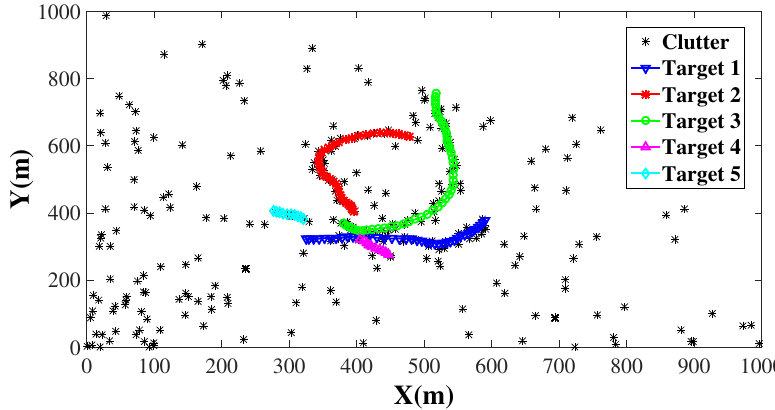
Figure 2. Ground-truth trajectories of five targets with the clutter number setting to be 10. The target trajectories are depicted by circle-solid lines with different colors, while the asterisks denote clutters. For parameters, we set the gating threshold T h = 16 according to [32], the probability of detection and survival are p d ( x k ) = 0.95, and p s ( x k ) = 0.99, in accordance with [36]. The particle numbers